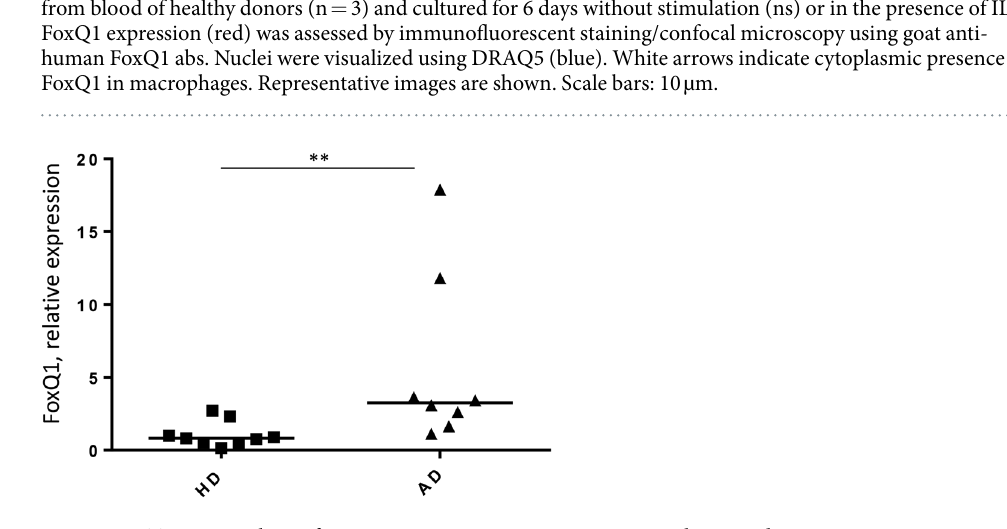
Figure 3. RT-qPCR analysis of FoxQ1 mRNA expression in patients with atopic dermatitis. Monocytes were isolated from blood of patients with AD (n = 8) and healthy donors (n = 9) and directly used for RNA isolation. ** p = 0.0016, Mann-Whitney U